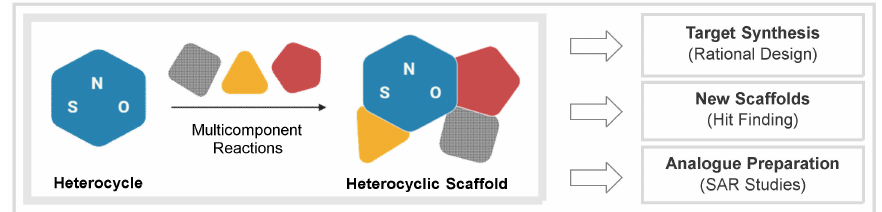
Figure 1. Heterocycle-based MCRs for MedChem